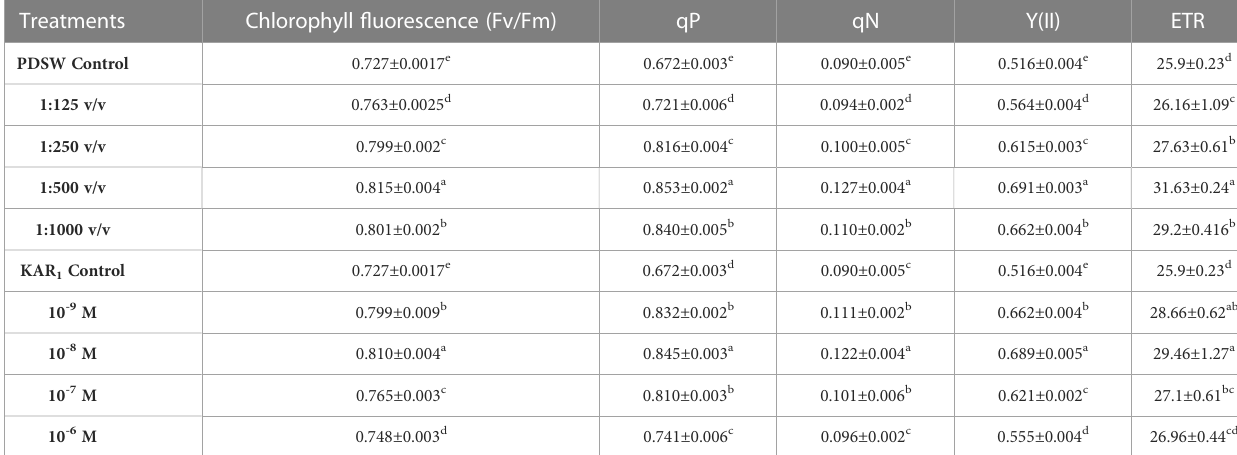
TABLE 2 Effect of foliar application with PDSW and KAR 1 on chlorophyll fl uorescence (Fv/Fm) and the related parameters (qP, qN, Y(II), ETR) measured on the leaves of Mentha arvensis L. at 90 DAP (days after plantation). Treatments